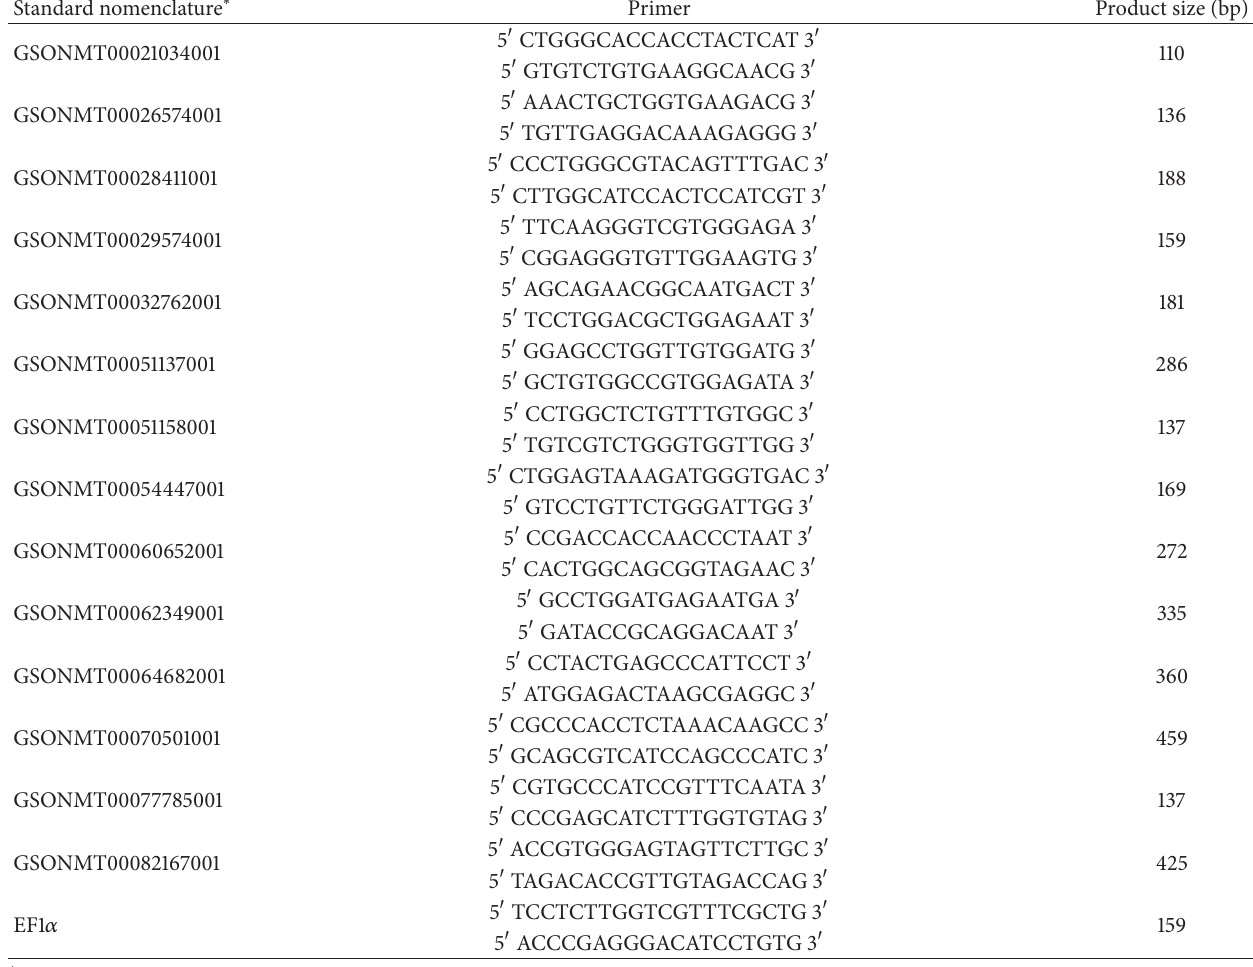
Table 1: The information of the primer pairs used to analyze gene expression by real-time quantitative